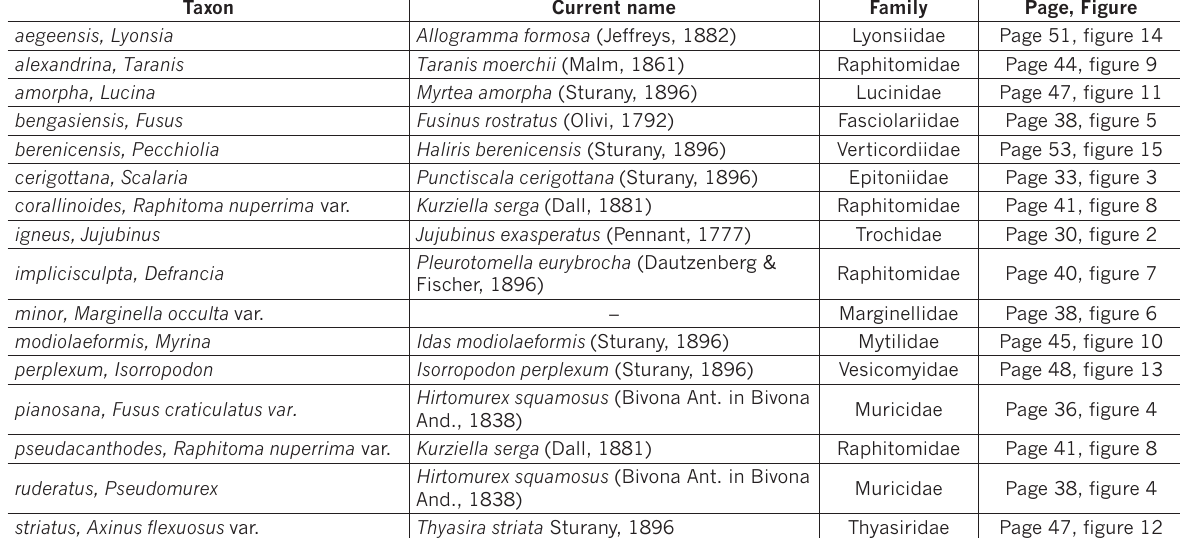
Figure 1. Map of the stations sampled by the “Pola” expeditions to the Eastern Mediterranean (1890-1893) and the Southern Adriatic Sea (1894) which provided molluscan samples and reported in Sturany Table 1. List of treated taxa in alphabetic order, with original name, current family placement, and figure in this paper.